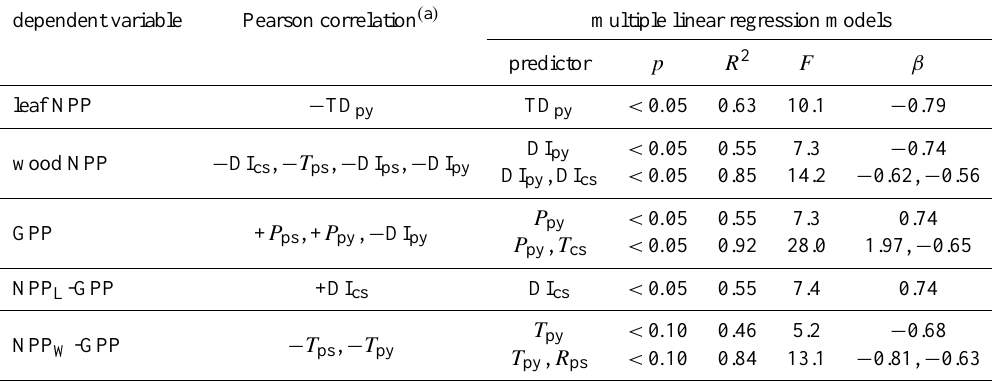
Table 3. Relationships between forest production and environmental and stand variables for the beech stand of Hesse between 1997 and 2004. Results are based on correlations (Pearson correlation and multiple linear regressions) between 8 replicates of NPP, GPP and NPP- GPP ratio (both for leaves, NPP L -GPP, and wood, NPP W -GPP) and 13 independent variables (the most important variables are: TD py : tree density previous year; DI cs , DI ps and DI py : drought intensity index of the current growing season, previous growing season and previous year, respectively; T cs , T ps and T py : air temperature of the current growing season, previous growing season and previous year, respectively; P ps and P py : precipitation of the previous growing season and previous year, respectively; R ps : global radiation of the previous growing season). Degrees of freedom are 6 for models with one predictor and 5 for models with two predictors. The R 2 is the explained variance, F indicates the model prediction performance vs. the model inaccuracy and β the standardized equation coefficients which indicate the importance of the model predictors. dependent variable Pearson correlation ( a ) multiple linear regression models